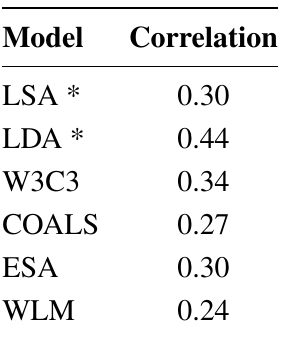
Table 13. Spearman rank correlations with backward associative strength for DRM lists (N = 55).